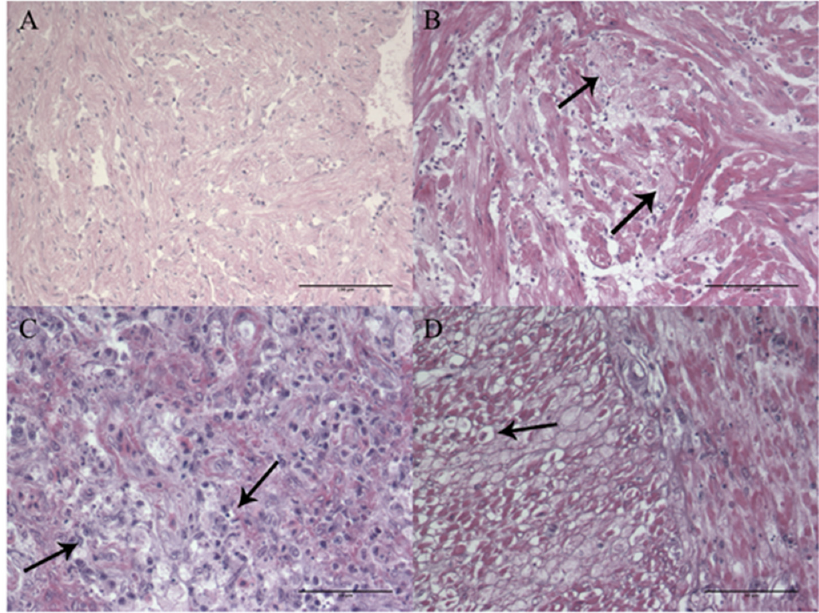
Figure 3. ( A – D ). Hematoxylin-erythrosine-saffron (HES) staining of paraffin sections from Atlantic cod ( Gadus morhua ) juveniles. ( A ) Heart from control fish 14 dpc. Scale bar 100 μ m. ( B ) Heart of fish sampled 7 days dpc, showing pathology and degeneration of the myocardium (Arrows). Scale bar 100 μ m. ( C ) Spleen from fish sampled 7 dpc, showing severe necrosis and degeneration of hematopoietic tissue (Arrows). Scale bar 50 μ m. ( D ) Intestine of fish sampled 16 dpc, showing necrosis in muscularis circularis and muscularis transversum (Arrow). Scale bar 50 μ m.